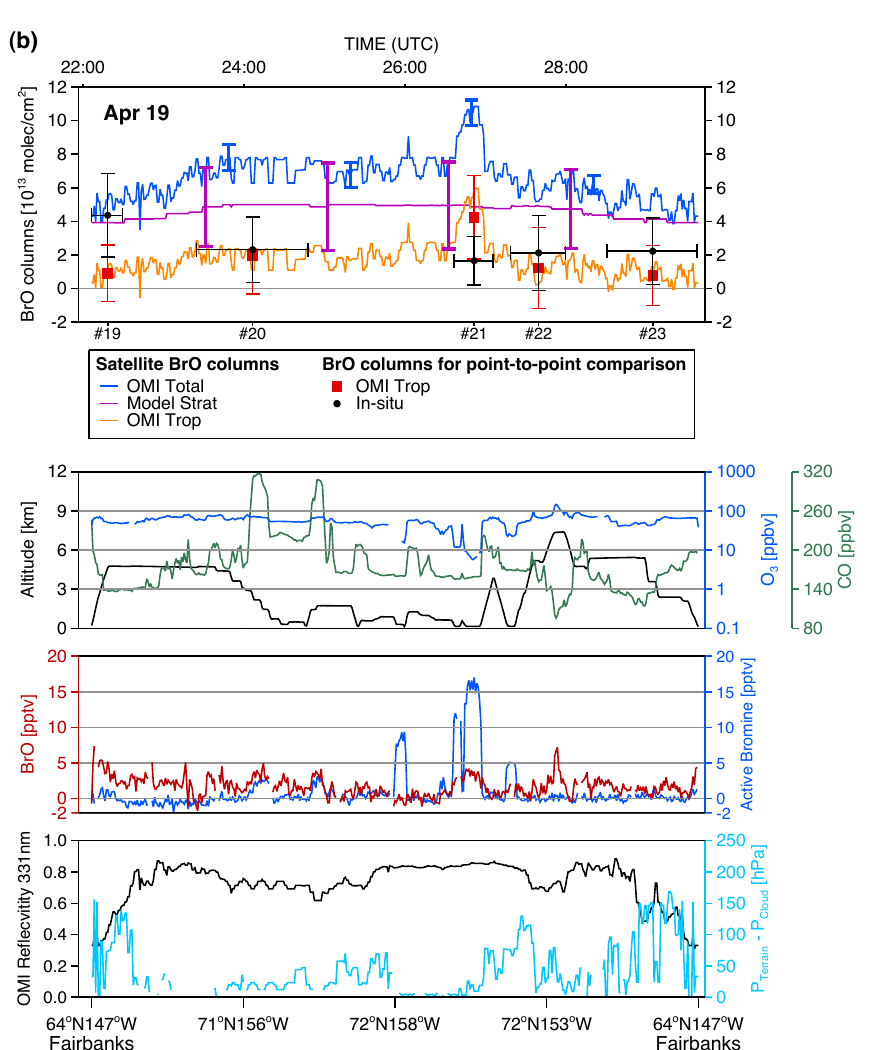
Fig. 9b. Similar to Fig. 6b but for the WP-3D flight on 19 April 2008. Soluble bromide was not measured from the WP-3D.